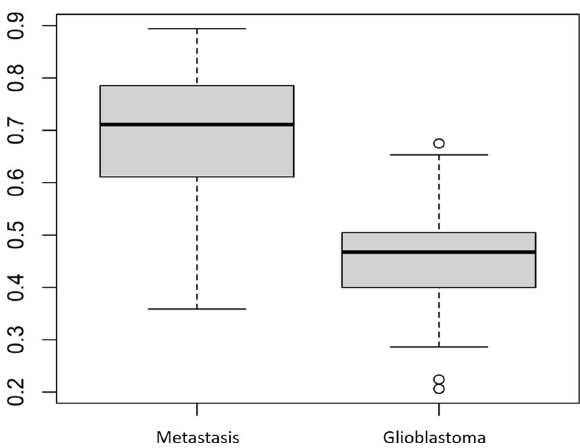
Figure 4. Feature importance. A boxplot showing the distribution of shape sphericity feature for the two tumor types on FLAIR